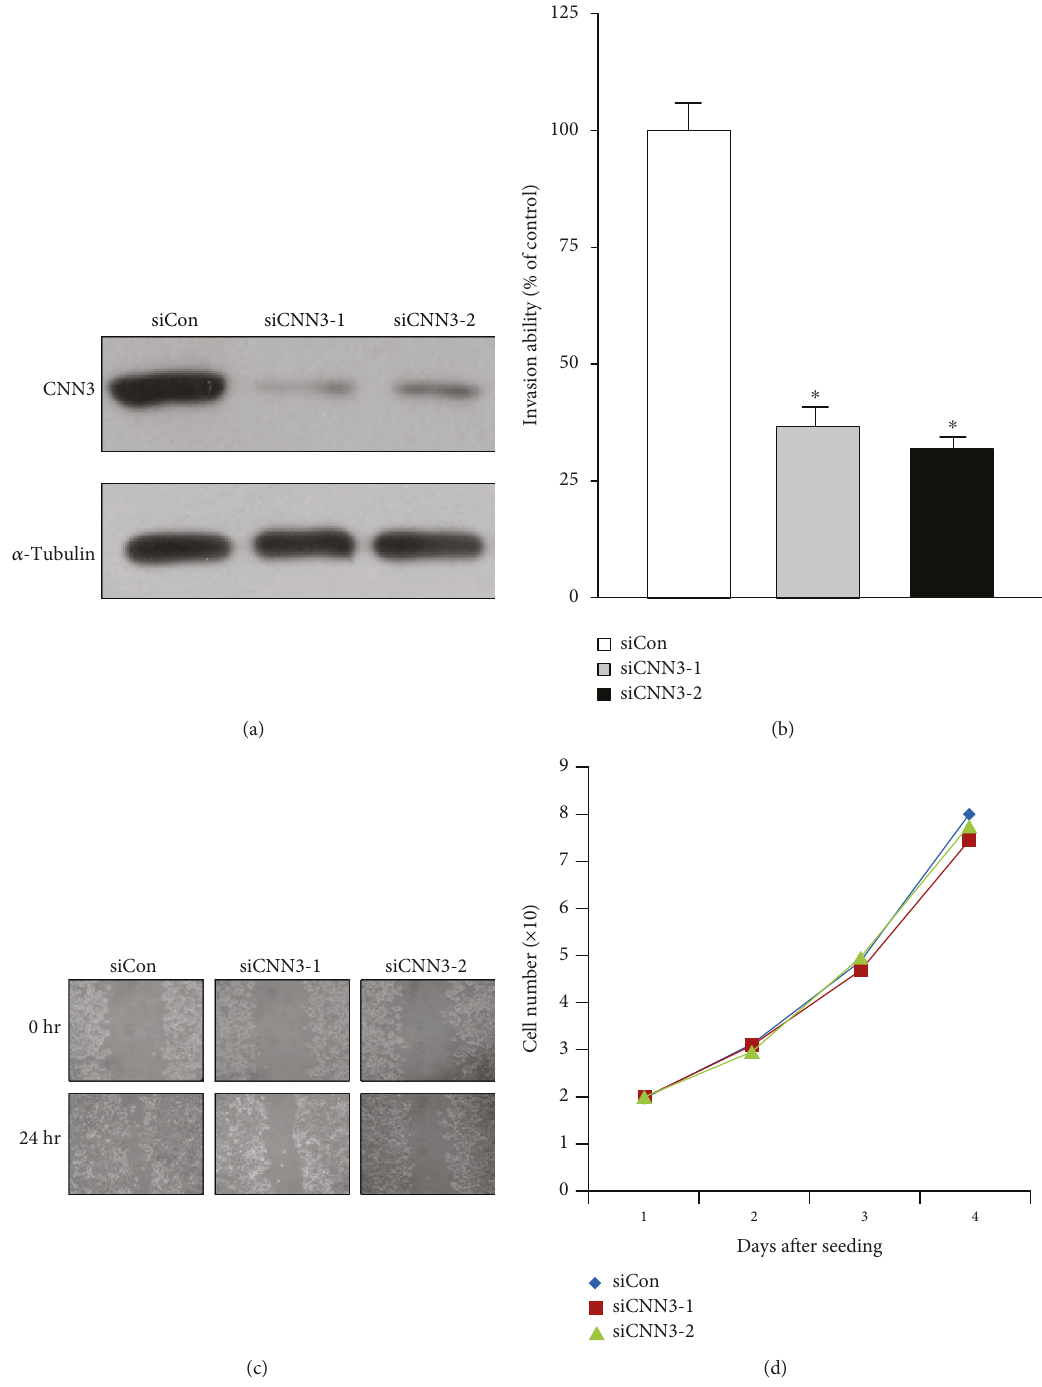
Figure 2: CNN3 is important for the invasiveness of MKN-28 gastric cancer cells. (a) MKN-28 cells were transfected with control (siCon) or two di ff erent CNN3-speci fi c siRNAs (siCNN3-1 and siCNN3-2) using siLentFect Lipid Reagent. Western blot analysis was performed against indicated antibodies. (b) Control siRNA- and CNN3 siRNA-transfected MKN-28 cells were seeded onto Matrigel matrix-coated upper chambers. The invasion activity of each cell was represented as % of control cells. The data shown are expressed as the means ± SD of three individual experiments, each performed in triplicate. ∗ P < 0 01 as determined by t -test. (c) Control siRNA- and CNN3 siRNA-transfected MKN-28 cells were analyzed in wound-healing assays by visualizing wound closure via phase-contrast microscopy. (d) E ff ect of CNN3 depletion on the proliferation of MKN-28